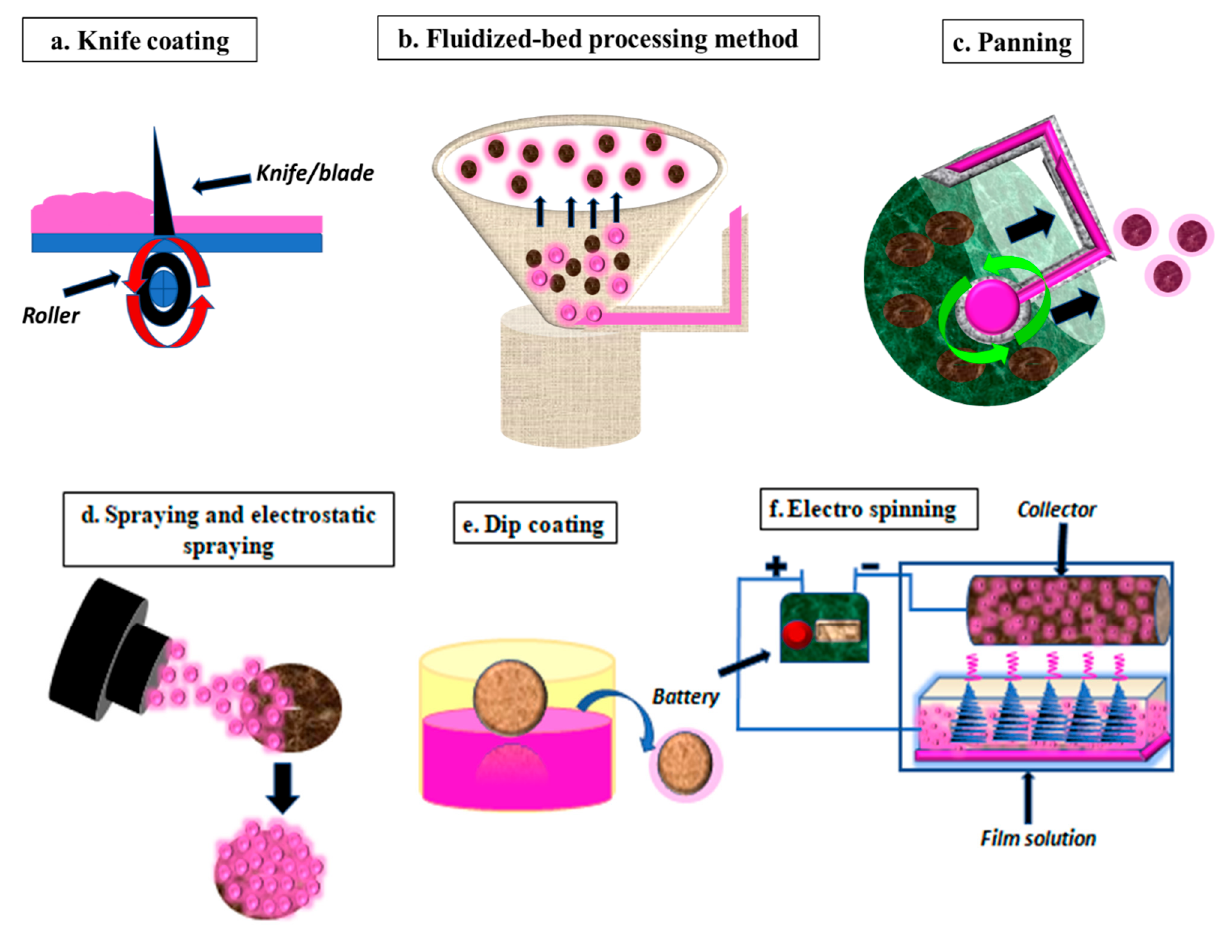
Figure 3. Various methods of film application ( a ) knife coating ( b ) fluidized-bed processing method ( c ) panning ( d ) spraying and electrostatic spraying ( e ) dip coating ( f ) electro